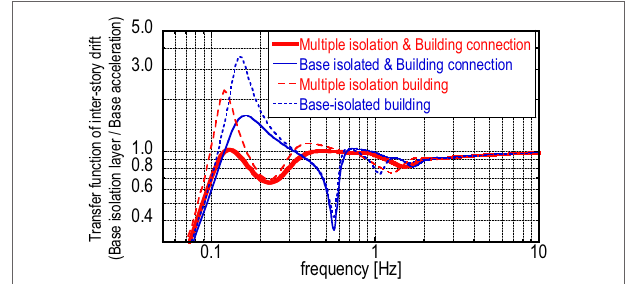
FIGURE 3 | Transfer function of inter-story drift (base-isolation layer/base acceleration) .